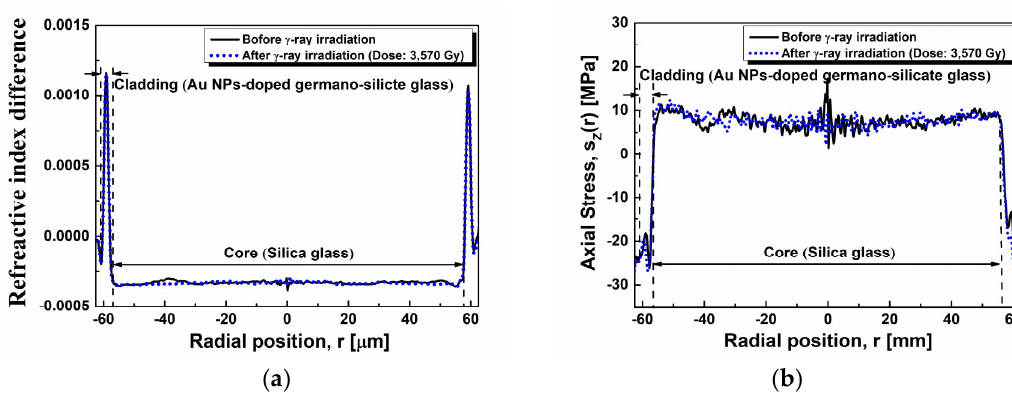
Figure 3. ( a ) Absorption spectra and ( b ) peak wavelength and intensity of the SPR band of the optical fiber incorporated with Au NPs before and after the γ‐ray irradiation at the total dose of 1190 Gy, 2380 Gy, and 3570 Gy. To verify the existence of Au NPs in the fiber cladding again, optical absorption was measured by the cut‐back method. Figure 3a compares the optical absorption spectra of the fibers before and after the γ‐ray irradiation at the total dose of 1190 Gy, 2380 Gy, and 3570 Gy. Before irradiation, the absorption bands due to SPR were found to appear peaking at 392 nm (absorption coefficient α = 0.088 cm −1 ) and 509 nm (α = 0.066 cm −1 ), which depended on the particle size of Au NPs in the cladding of the fiber [5,8,52,72]. After the γ‐ray irradiation, the intensity and the peak wavelength of the two SPR bands were found to change. While the second SPR band at a longer wavelength of 509 nm has clearly shown the increase of its intensity and wavelength shift, the first SPR band at 392 nm has not shown any significant increase of its intensity and wavelength shift. With the increase of γ‐ray irradiation dose, the splitting of the SPR bands became more distinct [2,59–61]. The intensity of the second absorption band at 509 nm corresponding to the interparticle plasmon coupling of the